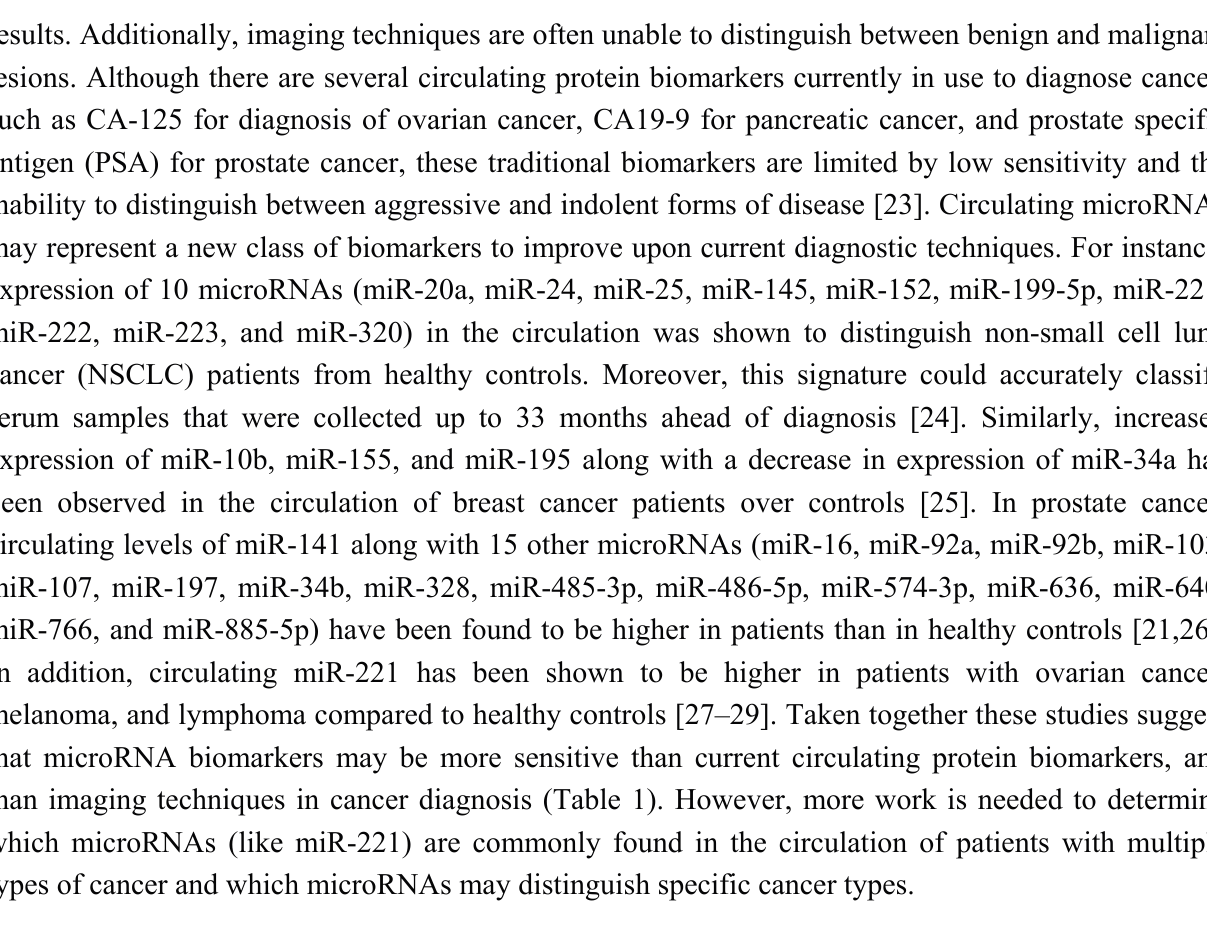
Table 1. MicroRNAs with potential as circulating biomarkers for diagnosis of cancer. Diagnostic